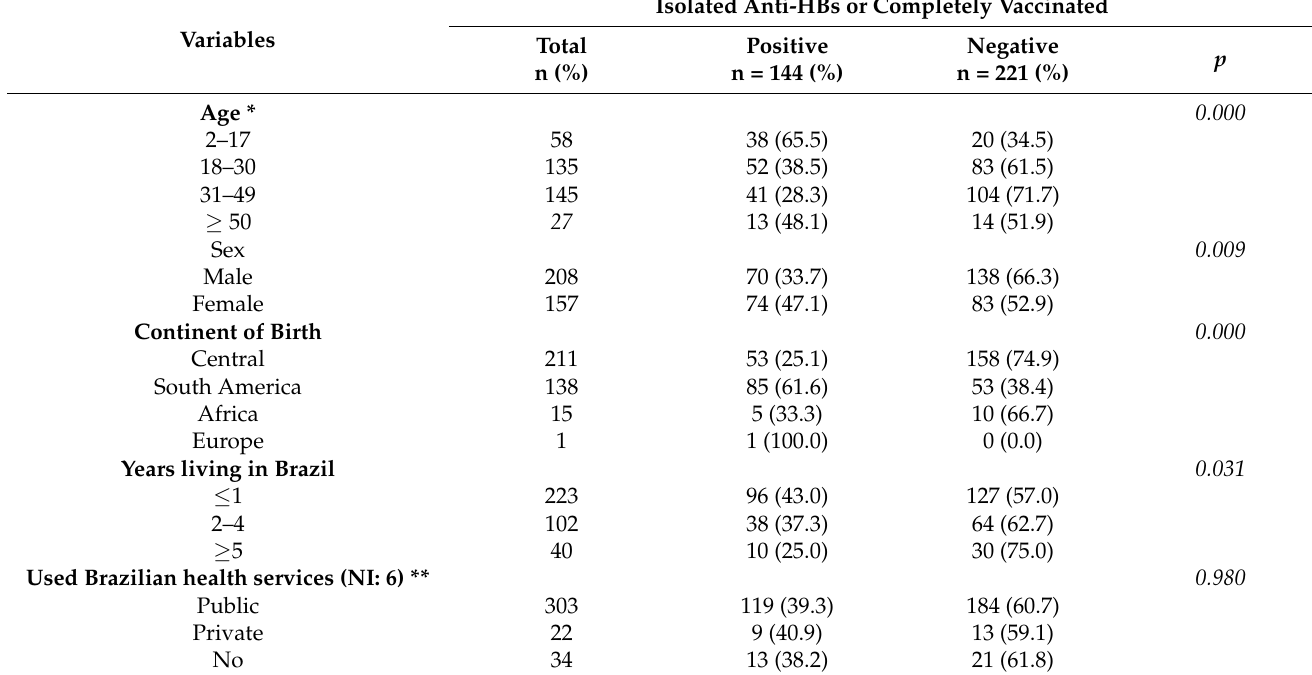
Table 4. Characteristics of the participants according to the serological status of immunization (isolated anti-HBs) or vaccination (three doses of hepatitis B vaccine) of 365 immigrants and refugees from the State of Goi á s, Brazil,